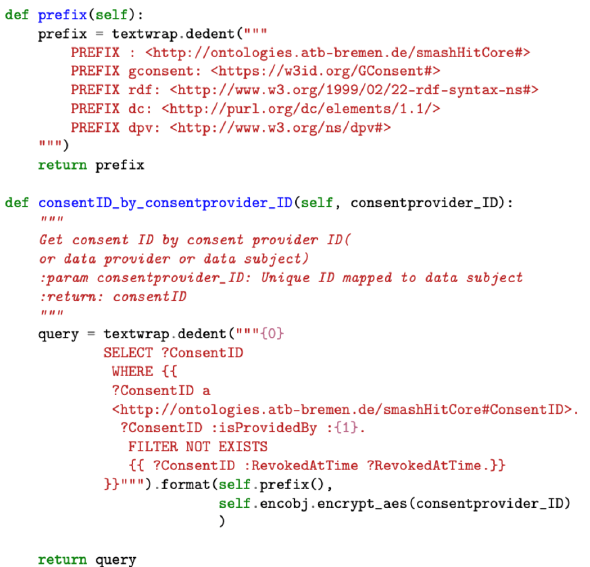
Figure 8. A snippet of code from the query processor module.